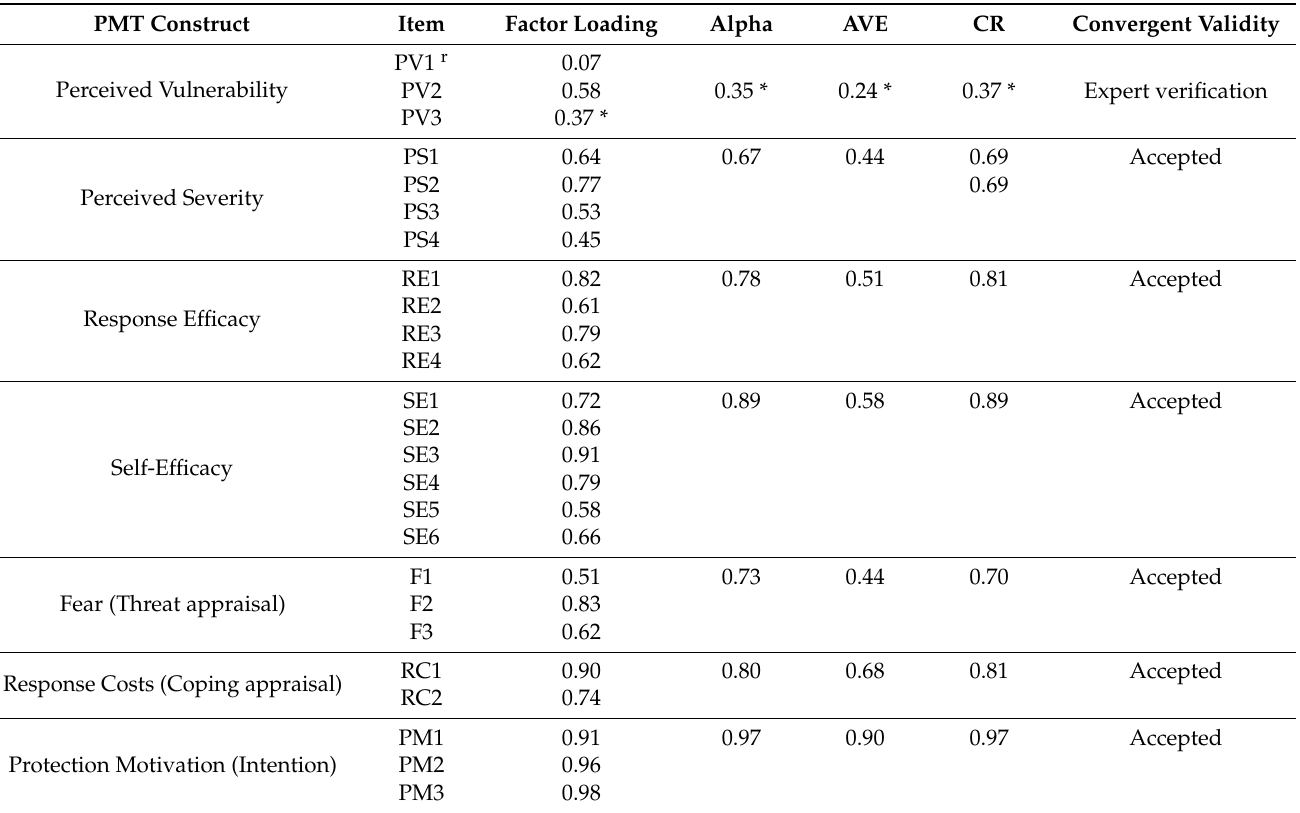
Table 4. The confirmation factor analysis (CFA).